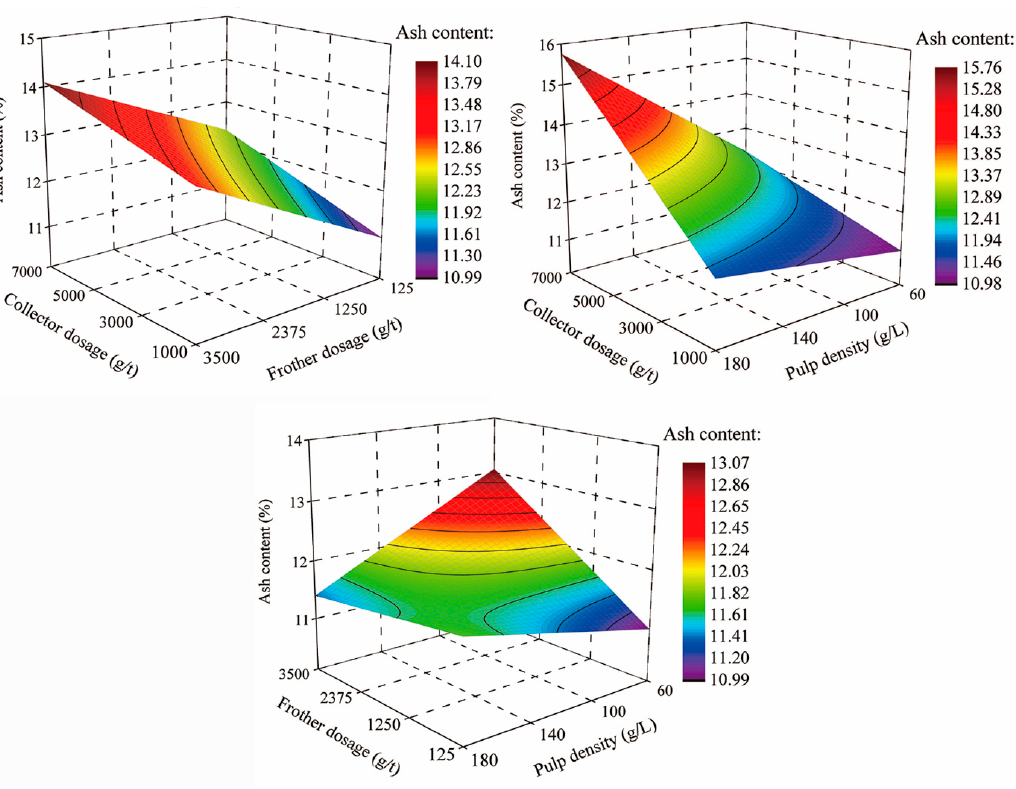
Figure 5. Response surface plots illustrating the interaction effects of the parameters on the ash content of the concentrate during rougher flotation in the mechanical flotation cell.